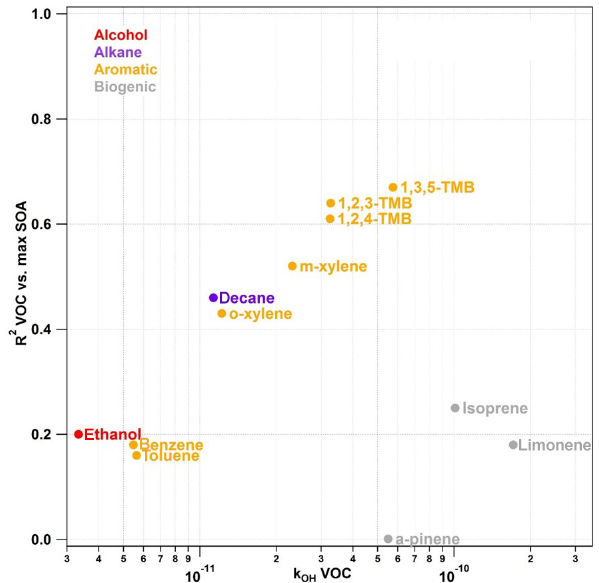
Figure 10. R 2 between the concentrations of different VOCs and the maximum amount of SOA formation in the OFR, plotted against the reaction rate constant of each VOC with OH ( k OH )